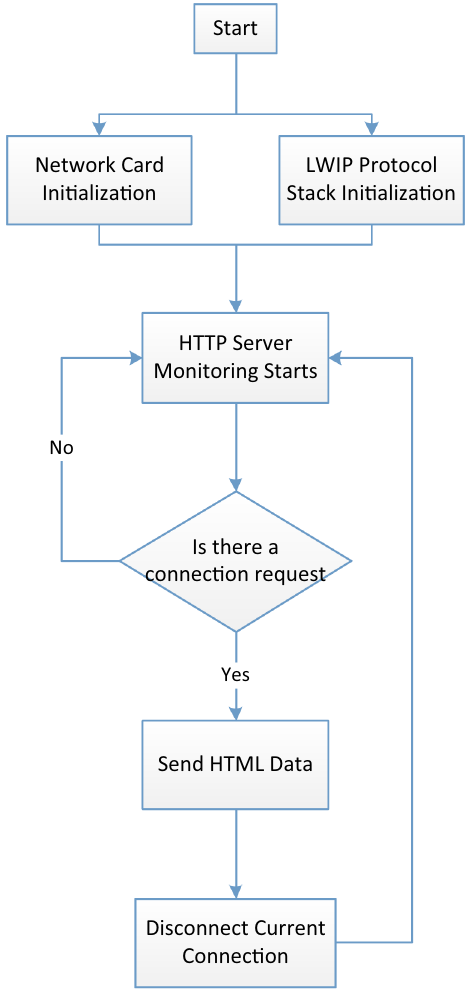
Figure 10. Workflow of the embedded web